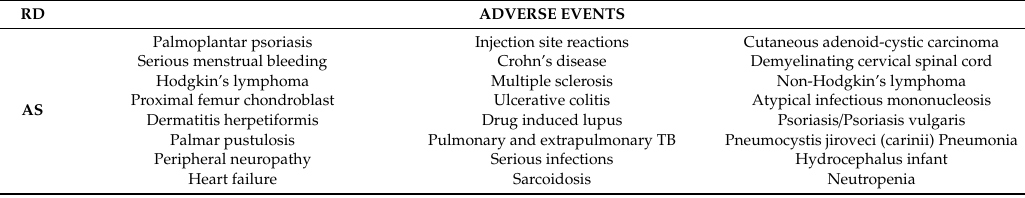
Table 3. Principal adverse e ff ects (AE) in rheumatic diseases (RDs) associated with biological drug